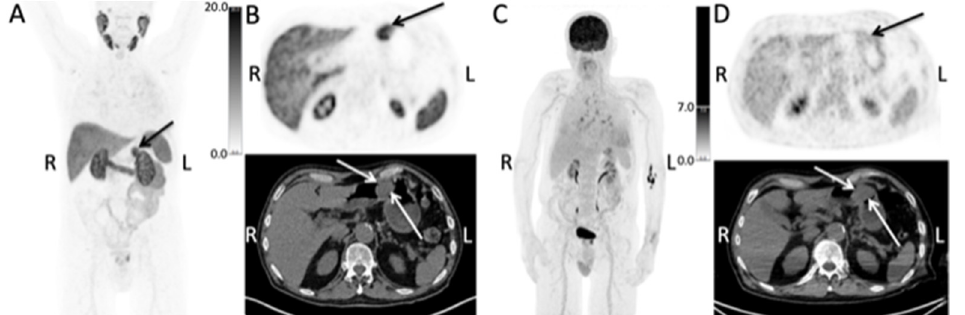
Figure 1. The maximum intensity projection (MIP) of the F-18-PSMA-1007 PET/CT ( A ) show a PSMA-positive lesion located in the upper abdomen (arrow) (R, right side; L, left side). Transaxial images of the of the F-18-PSMA-1007 PET/CT ( B ) show the PSMA-positive polyp in the body of the stomach, as indicated by the arrows. The maximum intensity projection (MIP) ( C ) and transaxial images ( D ) of the prior F-18-FDG PET/CT showed low FDG uptake in the polyp (arrows).